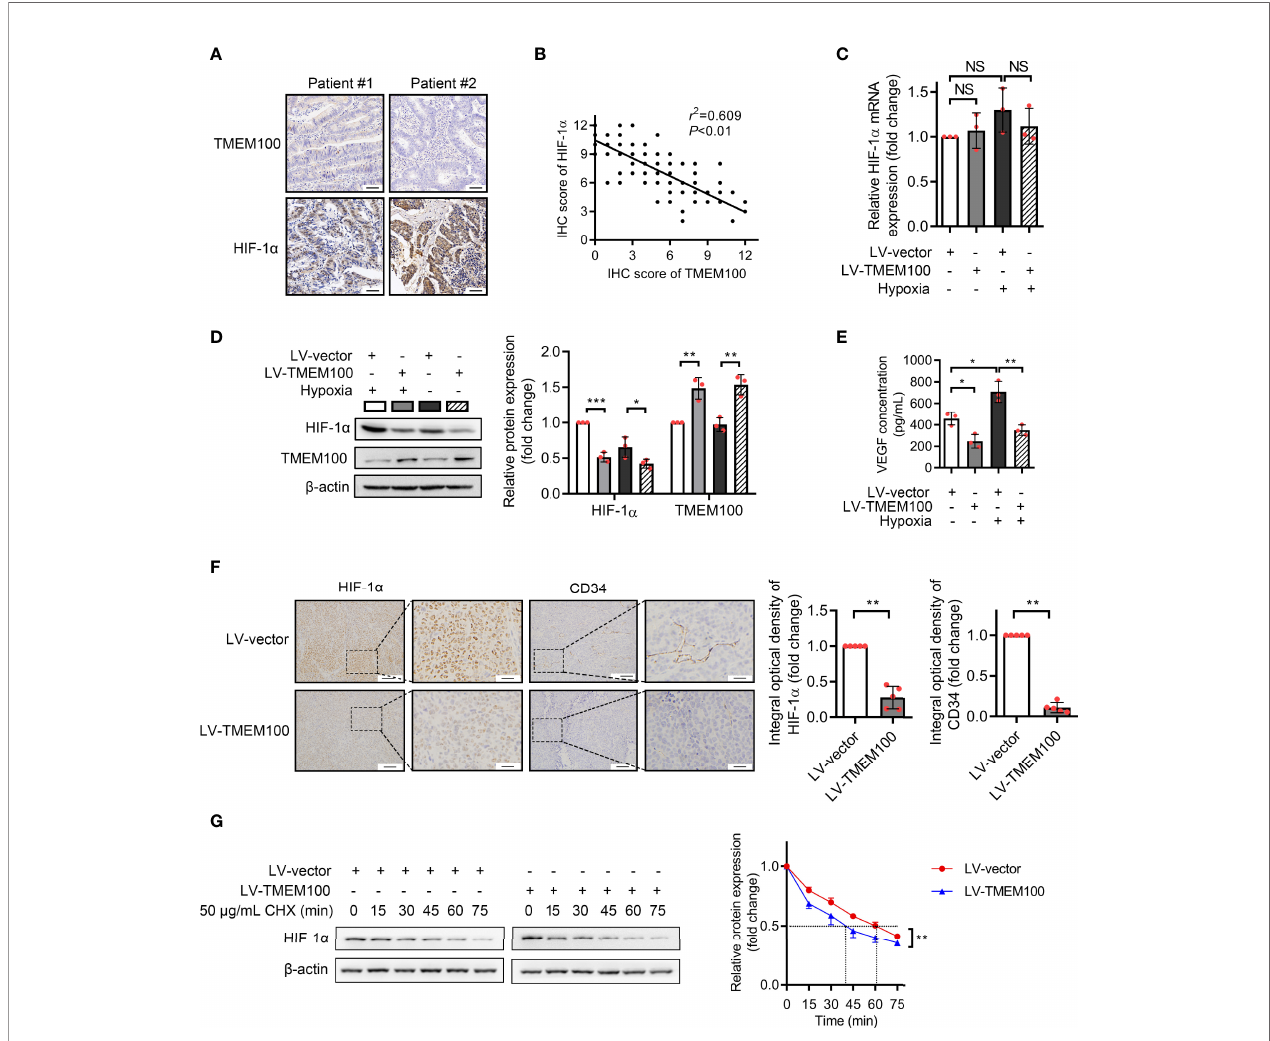
FIGURE 5 | TMEM100 overexpression leads to a reduction in HIF-1 a content and microvascular density in CRC. (A) Representative images of IHC staining of TMEM100 and HIF-1 a in CRC tissues. Scale bar = 100 m m. (B) The correlation between TMEM100 and HIF-1 a expression in CRC specimens was analyzed, and the linear correlation coef fi cient and statistical signi fi cance were indicated. (C) HCT116 cells were infected with LV-vector or LV-TMEM100 lentiviruses. The relative mRNA expression of HIF-1 a was detected by RT-qPCR in indicated cell under normoxic and hypoxic conditions. ANOVA. (D) TMEM100 and HIF-1 a expression in indicated cell was detected by western blotting. b -Actin was used as a reference control. Two-sided t-test. (E) The extracellular concentration of VEGF released by indicated cells was detected by ELISA. ANOVA. (F) The representative pictures of the HIF-1 a and CD34 expression of subcutaneous tumors (n=5/group) stained by IHC. Two-sided t-test. (G) Control or TMEM100 overexpression cells were incubated with cycloheximide (CHX, 50 m g/mL) for the indicated time. The cell lysates were then analyzed by western blotting. The dot lines indicated the half-life of the HIF-1 a . b -actin was used as a reference control. Two-sided t-test. Data are presented as the mean ± SD. * p <0.05, ** p <0.01, *** p <0.001. NS, no signi fi